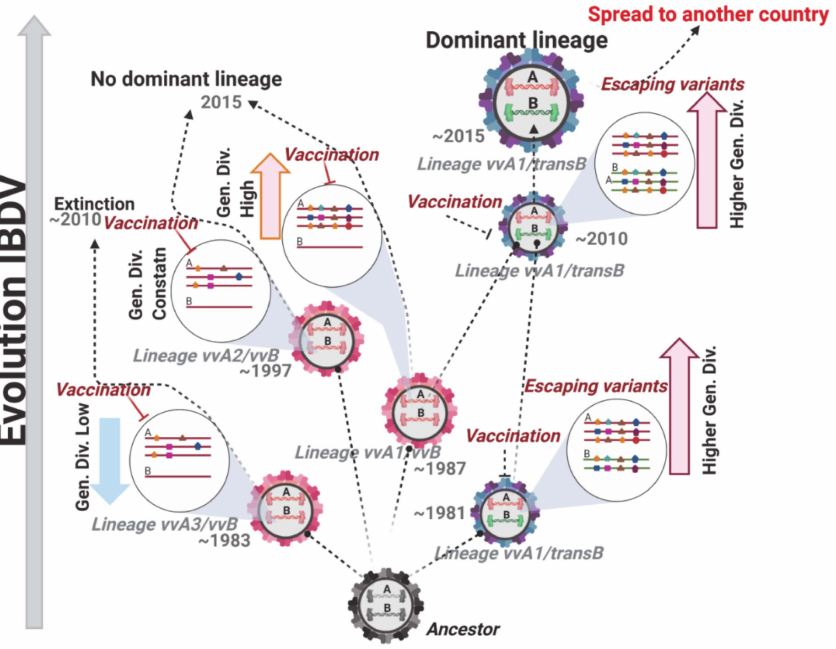
Figure 8. Shift in the dominant genotype strain of IBDV in the field. The evolutionary process of IBDV in the field, year of emergence, and genetic composition for each main lineage are shown. The illustration of quasispecies composition and the bottleneck of different severities induced by the vaccination are also denoted. Effective vaccination is shown in red, and unsuccessful vaccination is denoted in black. The effect of the bottleneck on mutant spectra is shown by denoting relevant adaptive mutations, which are hypothetically located and highlighted with colored